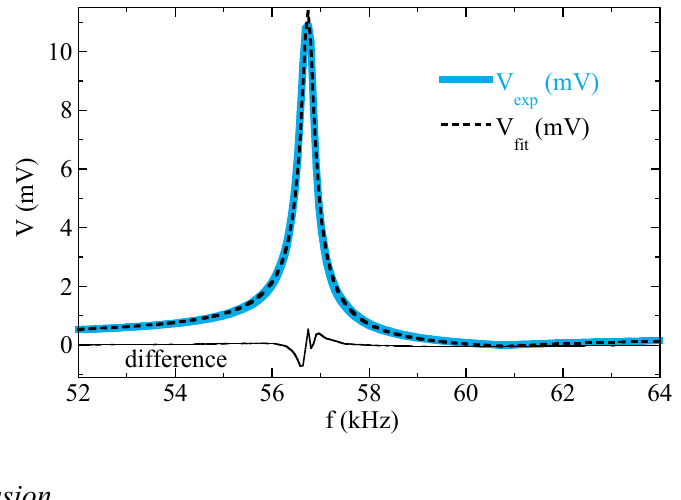
Figure 9. Fitting of a measured resonance curve to Equation (3). Best fit parameters are: f = 56.73 kHz; δ = 0.0022; f = 60.82 kHz; δ = 0.0121; A = 38.07 mV; r r a a 2 π a = 8.57 × 10 − 6 mV/Hz; b = − 55.97